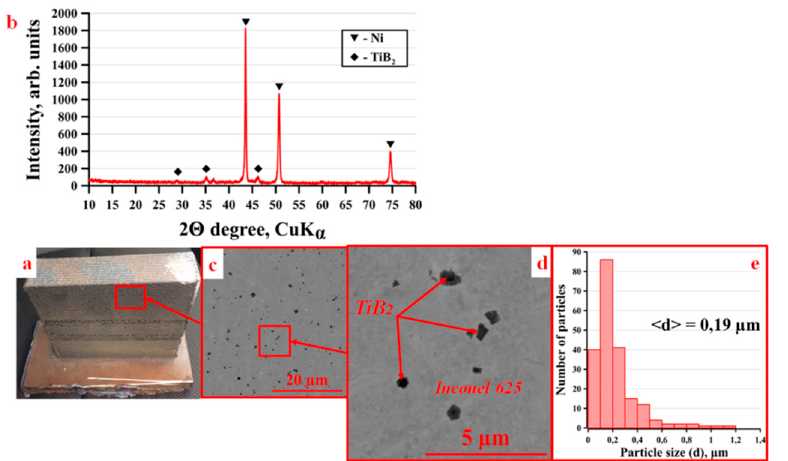
Figure 3. (a) Appearance of the materials obtained by selective laser deposition from a powder mix-